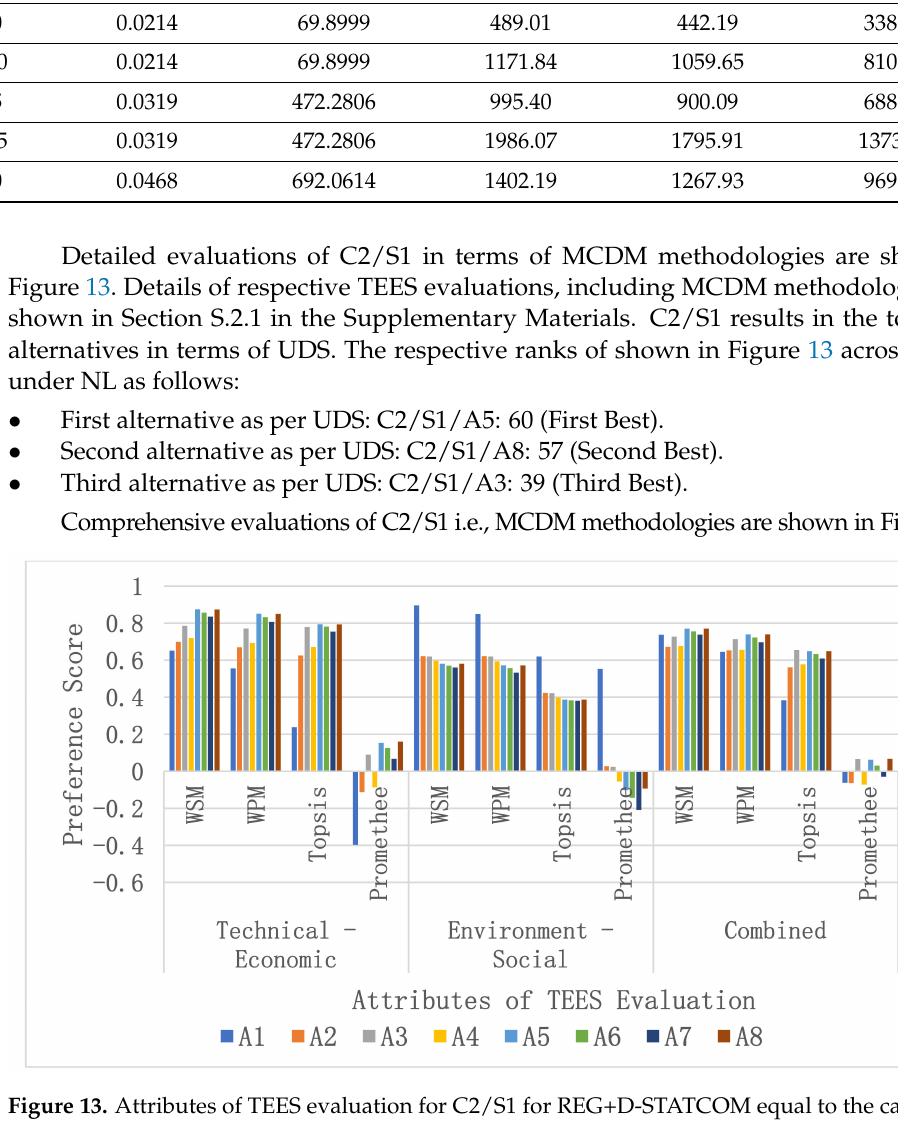
Figure 13. Attributes of TEES evaluation for C2/S1 for REG+D-STATCOM equal to the capacity of DGs only at 0.90 LPF in the 33-bus MDN under